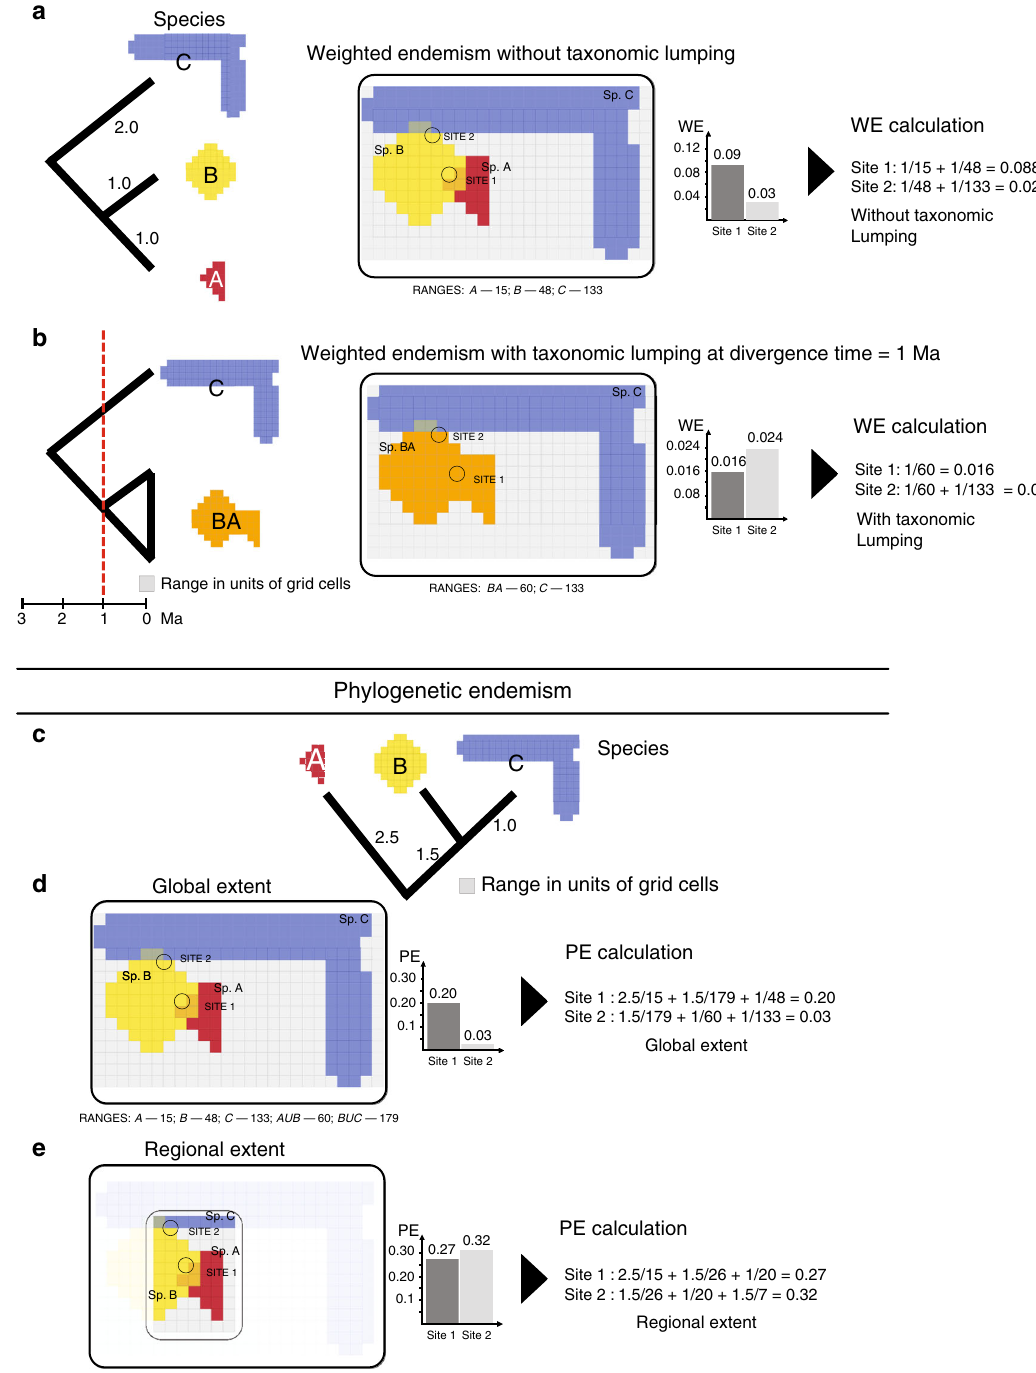
Fig. 1 Schematic of the variation of endemism with spatial extent, grain size and taxonomic treatment. a , b Changes in weighted endemism (species richness inversely weighted by species ranges) under a scenario of taxonomic lumping at a divergence time of 1 million years ago (Ma). As the node and ranges that originated at 1 Ma were collapsed ( b ), new hotspot maps of weighted endemism were generated which we compared with the original data ( a ). c Variation of phylogenetic endemism (the degree to which phylogenetic diversity is restricted to any given area) with spatial extent. d Spatial distribution of phylogenetic endemism across a global extent. At a global extent, phylogenetic endemism is calculated accounting for the full geographic range of the species. e Distribution of phylogenetic endemism (PE) at a regional extent (continent or country). When species ranges span socio-political borders such that phylogenetic endemism is calculated regionally (within a continent or country) without consideration of a species ’ (or even a clade ’ s) full range, an in fl ation of phylogenetic endemism results. Sites 1 and 2 refer to the area of circle overlapping with the cells (species ranges)